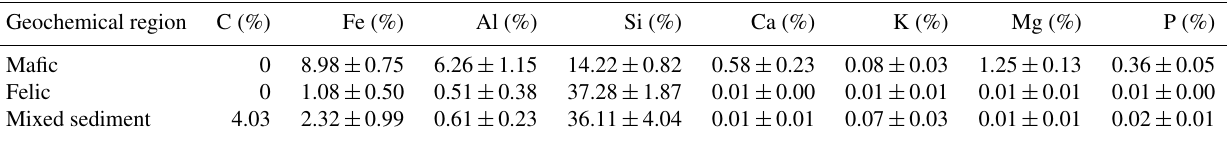
Table 1. Chemical composition of unweathered rock samples representing the soil parent material in the investigated three geochemical regions. Values represent mean ± standard errors ( n = 6, 10 and 3 for mafic, felsic and mixed sediment, respectively). Source: Project TropSOC Database Version 1.0 (Doetterl et al.,